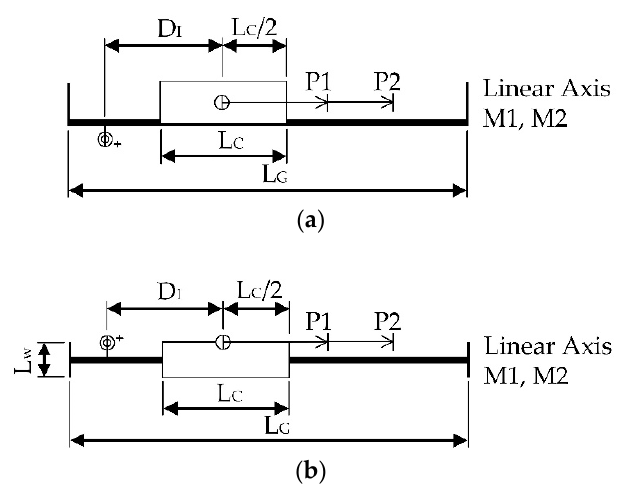
Figure 8. Combination of mechanical simplifications and graphic representation of the motion program. ( a ) Side view. ( b ) Top view.